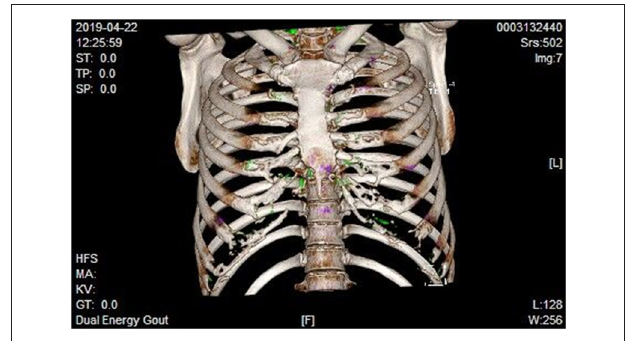
FIGURE 1 | Dual-energy CT examination of the chest. Urate crystal deposition is indicated in green.